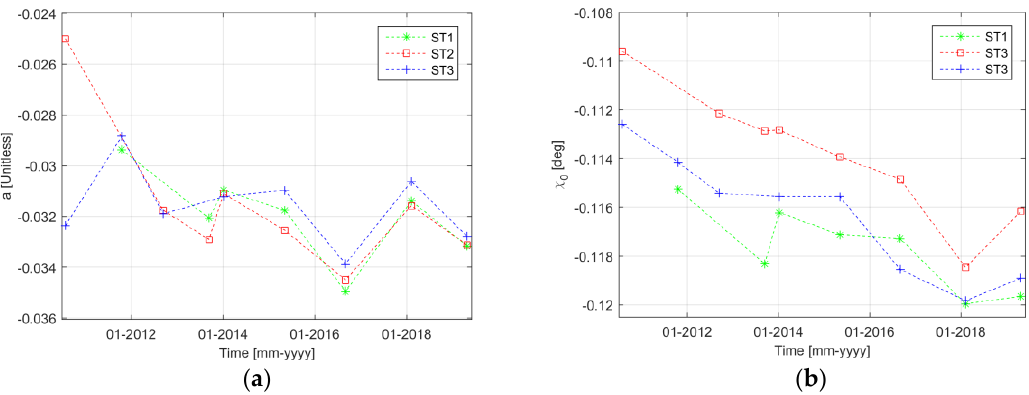
Figure 6. Calibration function parameters from Baseline-C L1b products: ( a ) linear coefficient a and ( b ) constant term 𝜒 0 .